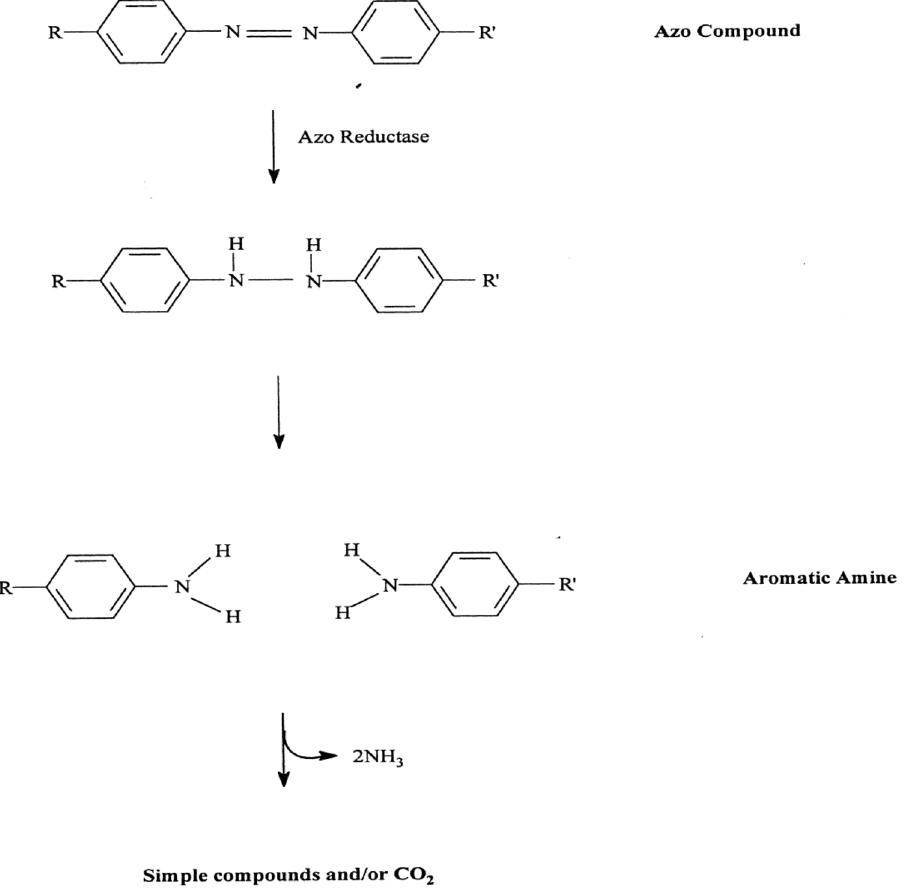
Figure 9. Degradation of azo dyes by